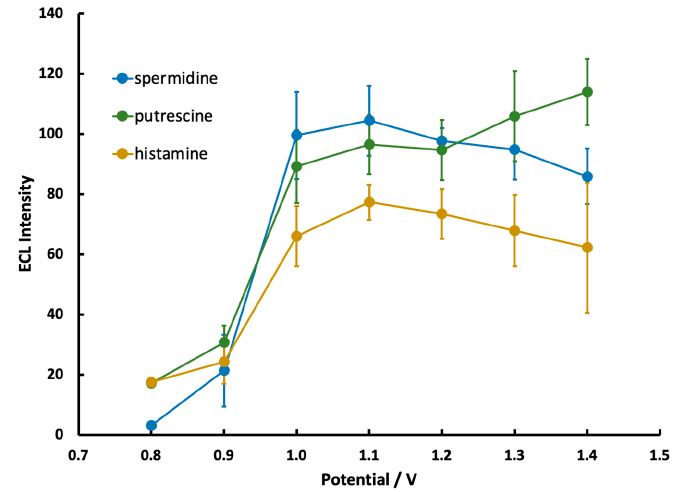
Figure 5. ECL intensity from the mobile phone detector as a function of applied potential for solutions containing 5.0 mM Ru(bpy) 32+ and 1.35 mM spermidine, putrescine, or histamine (n = 6 over two different electrodes).